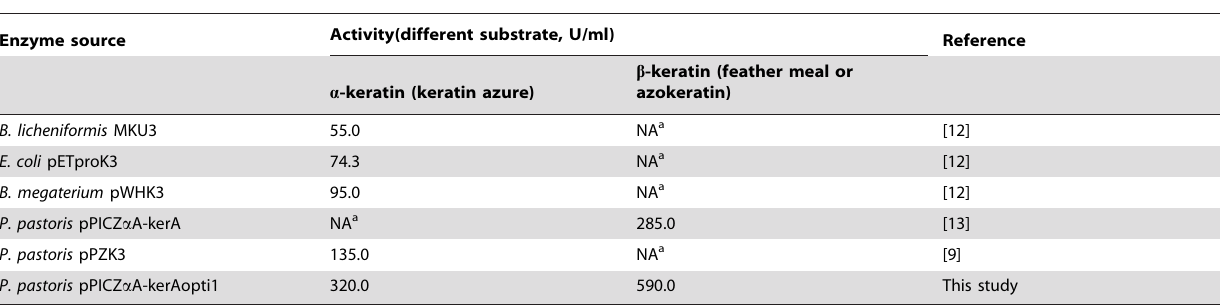
Table 3. Comparison of keratinase activity from different source.